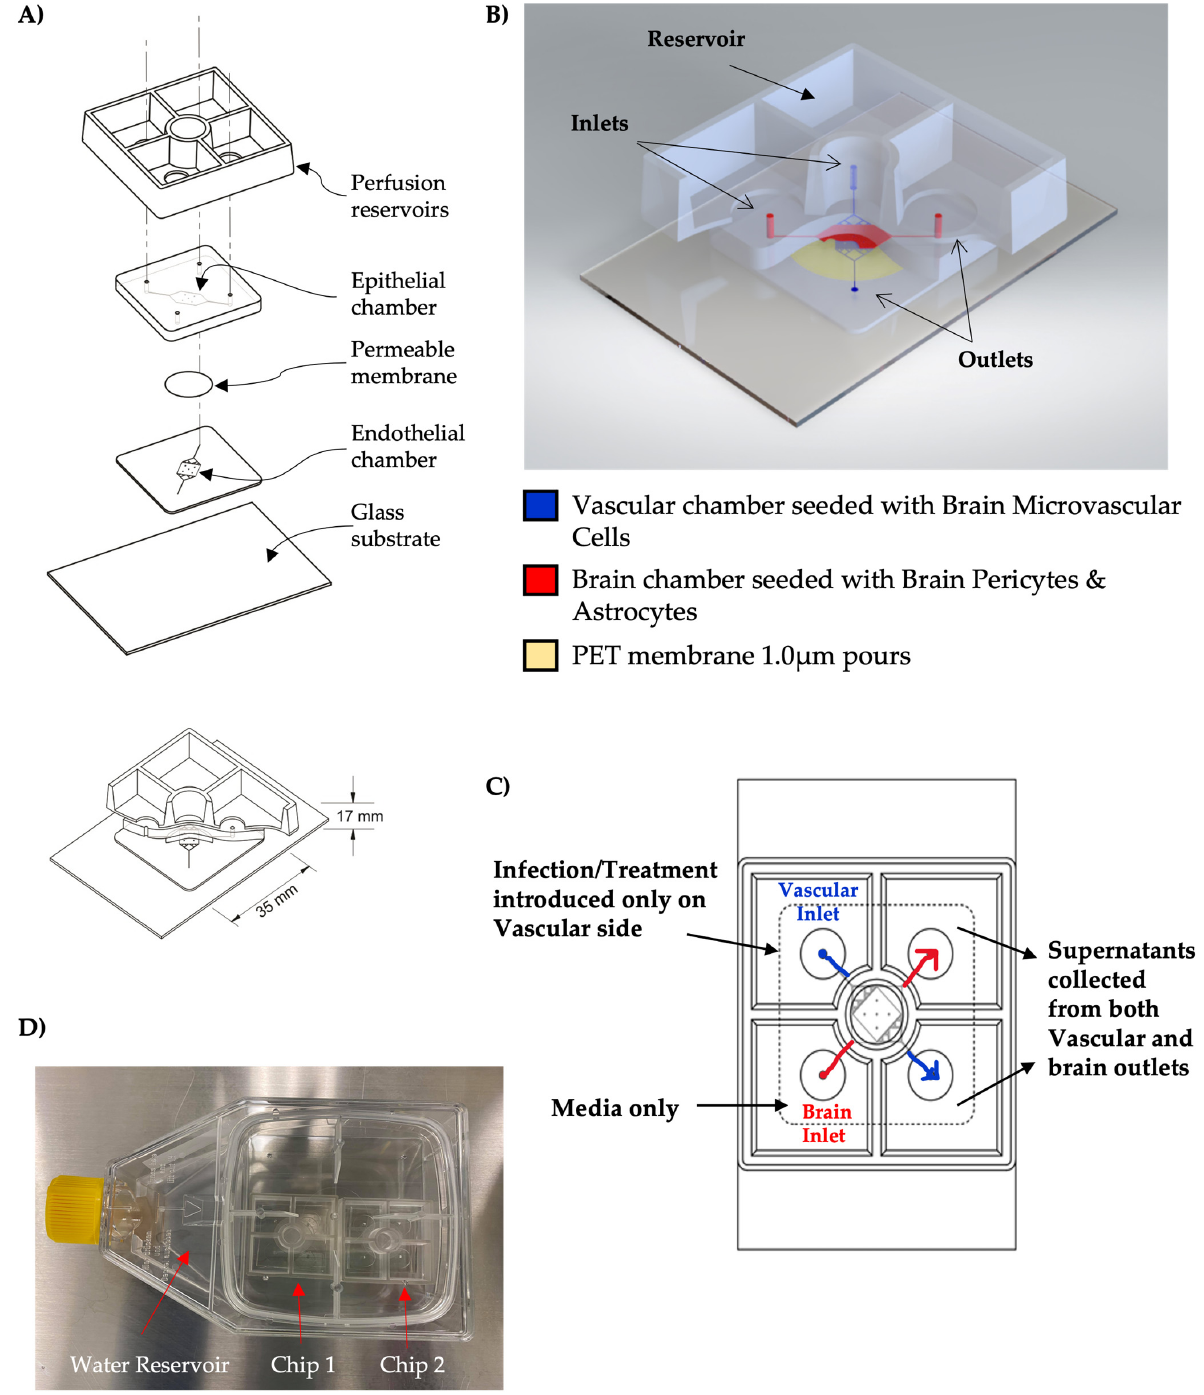
Figure 1. Schematic of the gNVU. ( A ) Artist’s rendering of the gNVU architecture; ( B ) positioning of the inlets and outlets are identified and the loading locations of the endothelial cells, astrocytes and pericytes are indicated; ( C ) the sites of introduction of the infection/therapeutic, control and sample collection sites are indicated. ( D ) Image of gNVU chips in a secondary container safe for use with select agents.